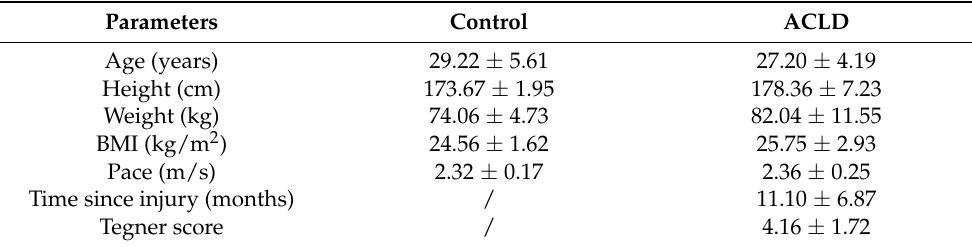
Table 1. Characteristics of the participants in each